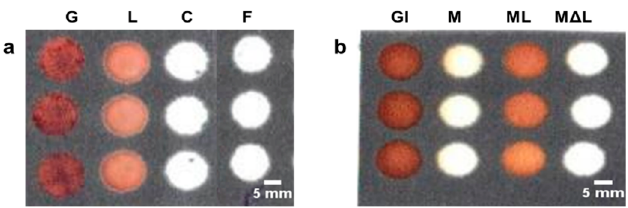
Figure 4. Testing biochemical compounds found in packaged fruit juices. ( a ) Testing of lactose by adding lactaid in milk; ( b ) testing fruit juice spoilage. GU: guaiacol; S: spoiled lemonade; C: control; F: fresh lemonade; Gl: glucose; M: milk; ML: milk + lactose; M Δ L: milk + heated lactose. (Scale bar: 3 mm).